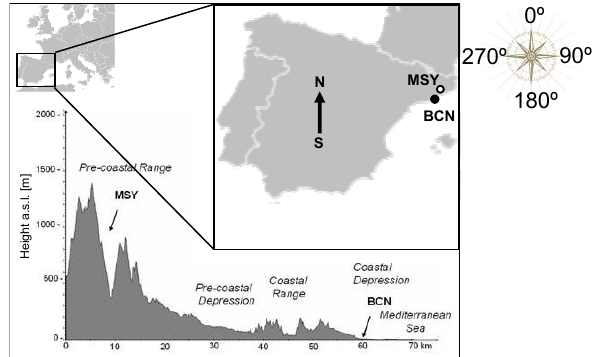
Fig. 1. Location of the Montseny measurement